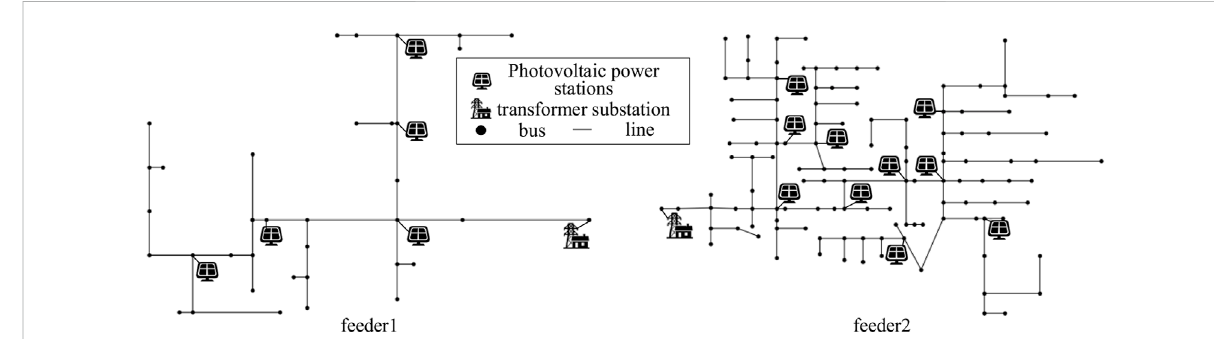
FIGURE 8 Schematic diagram of topology and photovoltaic location of feeder 1 and feeder two.